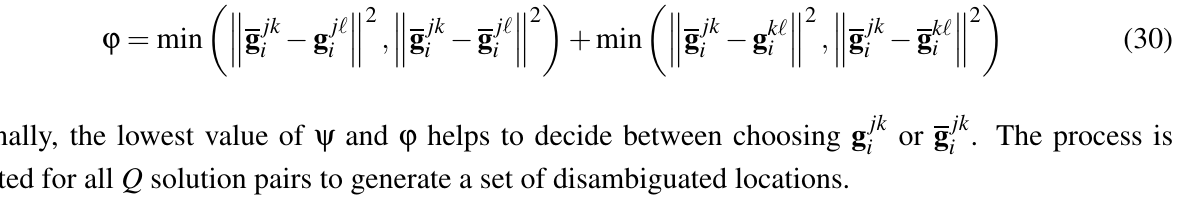
to get its initial position estimate p 0 i